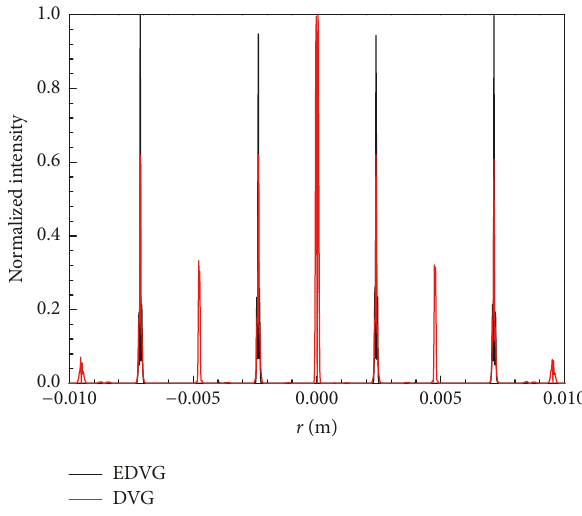
Figure 4: The normalized diffraction spectrum of DVG and